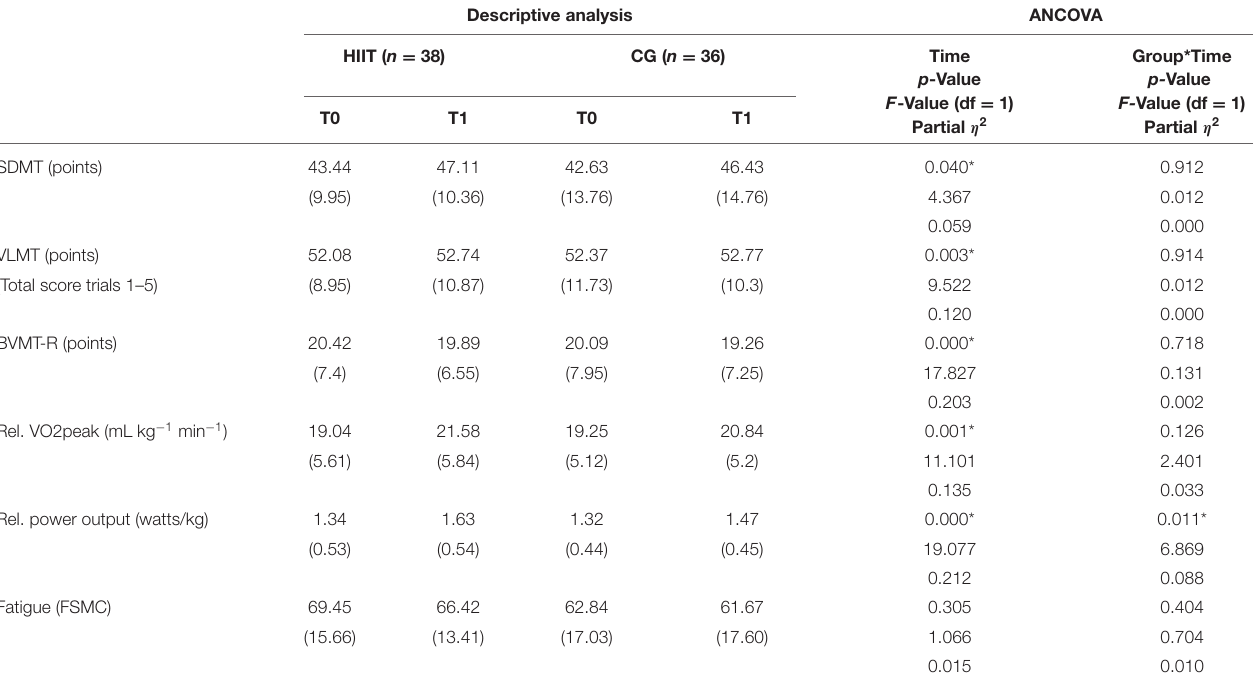
TABLE 2 | ANCOVA results of the overall analysis (HIIT vs.